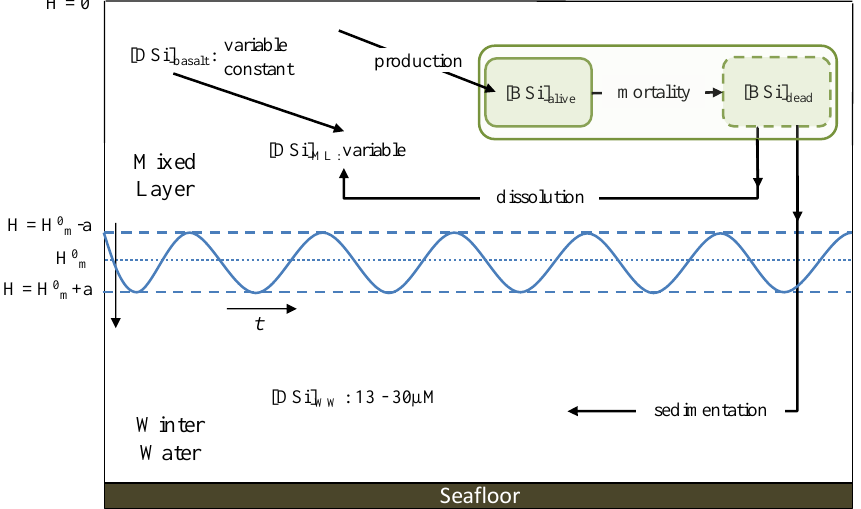
Fig. 2. Schematic representation of the box model, adapted from Platt et al. (2003). Dissolved silicon in the mixed layer (DSi ML ) is supplied by the Winter Water (WW) through mixing, by the dissolution of non-living diatoms (BSi D ) in the mixed layer (ML), and, in some runs, by the weathering of basalt (DSi bst ) . DSi bst can be null, a constant, or variable input to the ML. DSi ML is converted to living biomass (BSi A ) during diatom growth. BSi D is produced by mortality of BSi A . BSi D is exported by sedimentation and by mixing process, while BSi A is not allowed to sink. Concentrations of BSi A and BSi D can be diluted by mixing and losses can be incurred by deepening of the ML. The ML depth ( H m ) throughout the year is based on KERFIX data (Jeandel et al., 1998) following a time step t of 0.05d − 1 .